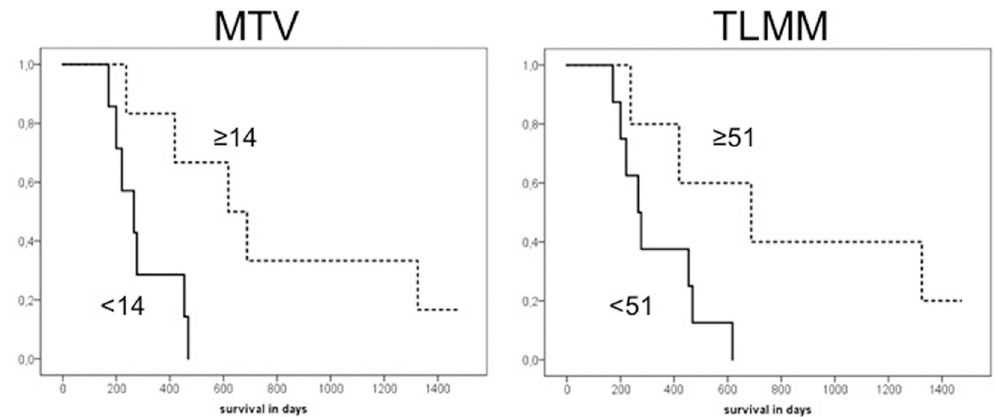
Fig 2. Kaplan-Meier curves for MTV and TLMM. Survival curves for MTV and TLMM. Dichotomisation of the data based on the median ( � 14 for MTV and � 51 for TLMM). The group with higher values is displayed with the dotted line while the group with lower values is displayed with the bold line. The survival difference between patients with higher and lower values was statistically significant for both MTV (p = 0.014) and TLMM (p = 0.041). Abbreviations: MTV = metabolic tumor volume, TLMM = total lesion methionine metabolism.